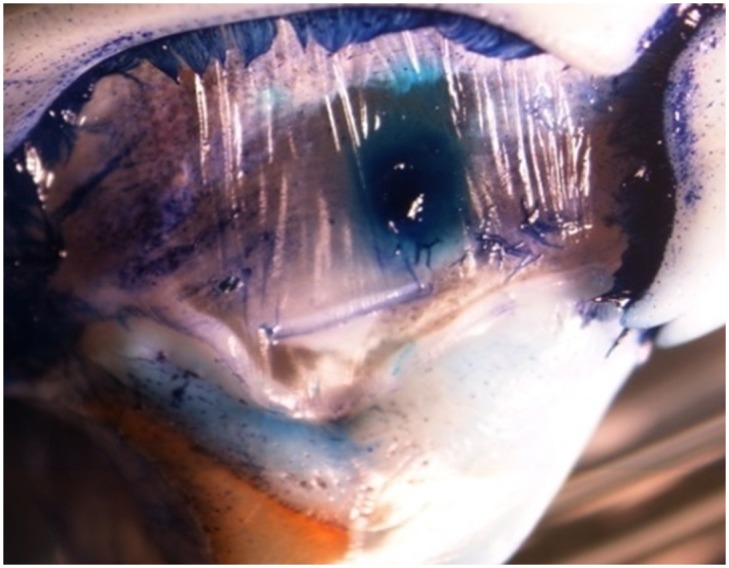
Injury to the arthrodial membrane of the coxa and swimming leg of Callinectes sapidus after an attack by Octopus maya.The prey was attacked from the rear side. (Methyl blue dye, stereoscopic microscope 3X).